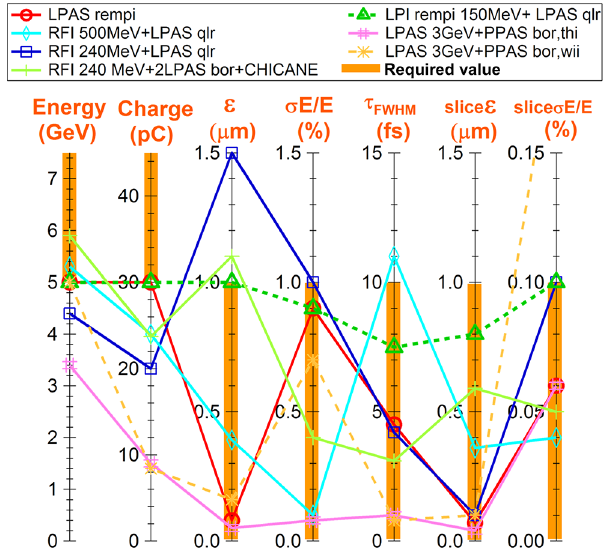
FIG. 3. Beam parameters obtained at the 5 GeV LPAS exit compared to the requirements for seven different acceleration techniques and beam injections. qlr and bor stand for, respec- tively, quasilinear regime and blowout